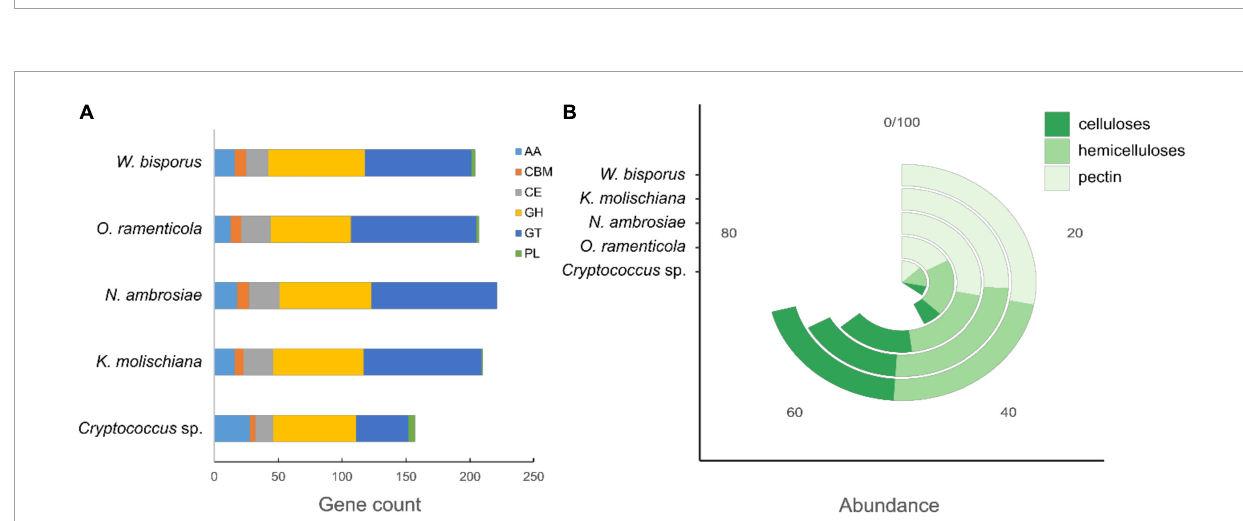
FIGURE3 Carbohydrate active enzymes (CAZymes) present in the yeasts’ genomes. (A) Comparison of CAZymes classes in five species. (B) Comparison of gene counts related to celluloses, hemicelluloses and pectin in six species. GT, glycosyl transferase; GH, glycoside hydrolase; CE, carbohydrate esterase; CBM, carbohydrate-binding module; PL, polysaccharide lyase; AA, auxiliary